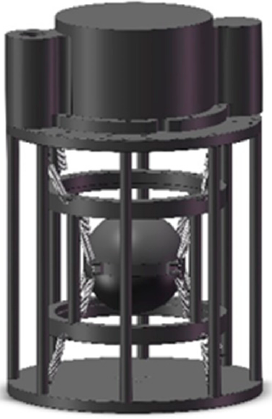
Figure 5. The schematic diagram of the TSSS assembly.